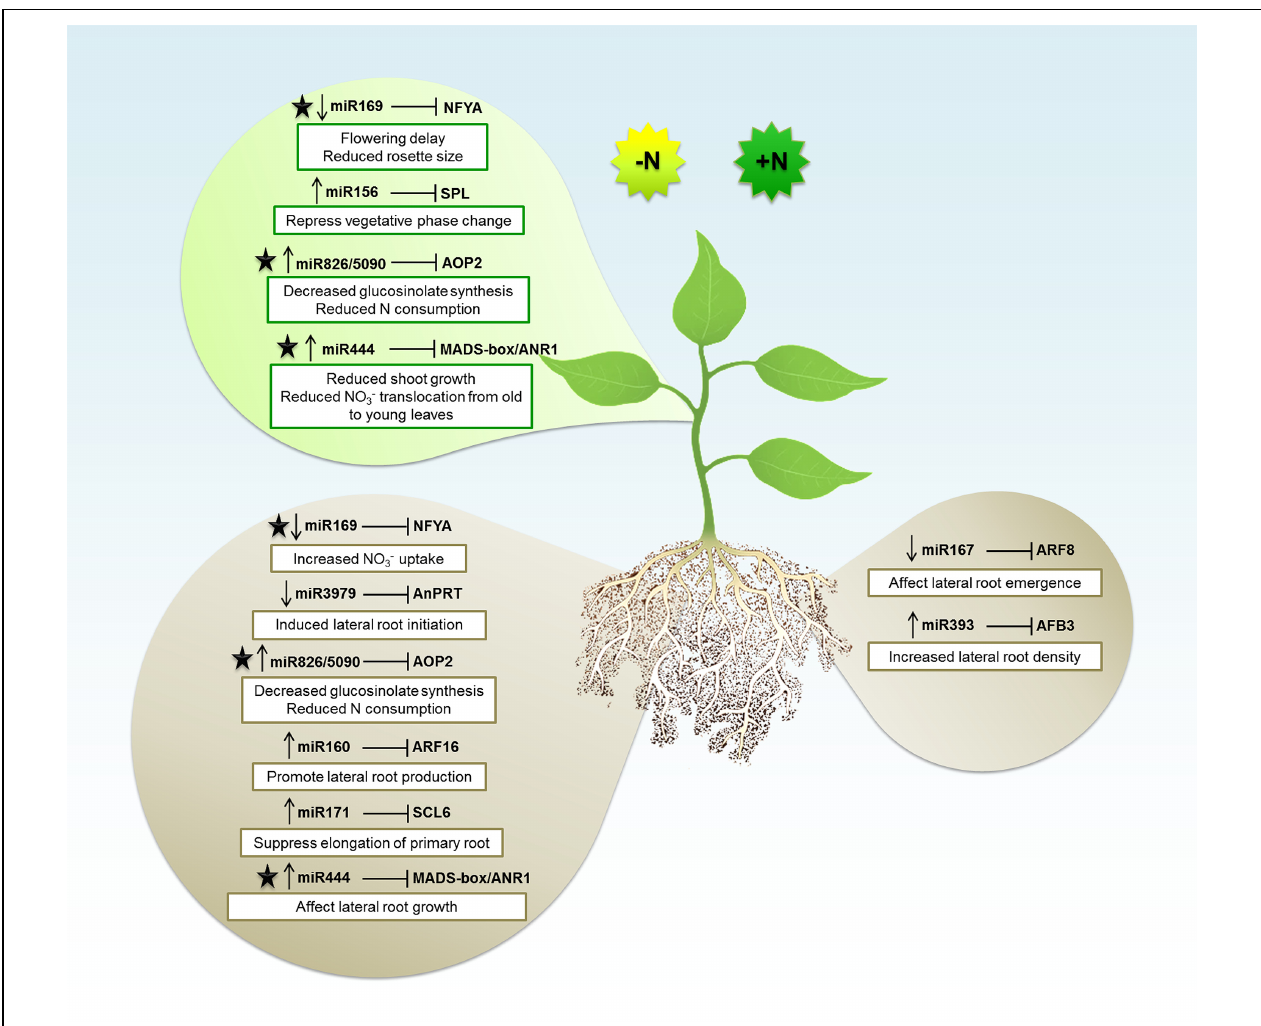
FIGURE 1 | The microRNA (miRNA) regulatory network in Nitrogen (N) signaling. The miRNAs expression patterns during N-deficient ( − N) or N-sufficient ( + N) in shoot (top balloon) or root (bottom balloons) tissues. Arrows pointing down and up indicate downregulation and upregulation, respectively. Each miRNA is associated with the mRNA target gene that is